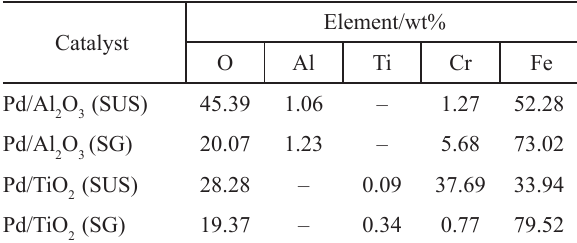
in fixed bed and mi- 2